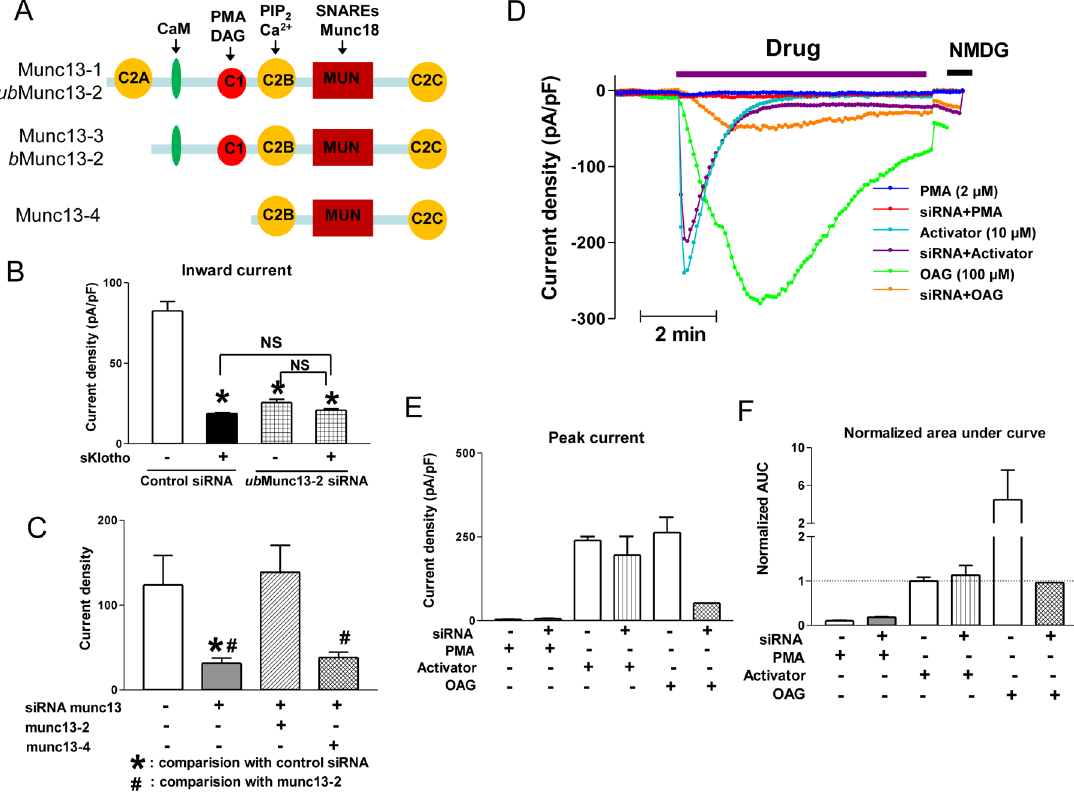
Fig 4. DAG stimulates TRPC6 exocytosis acting at Munc13-2. (A) Functional domains of Munc13 family proteins. ub Munc13-2; ubiquitously expressed Munc13-2; b Munc13-2, brain-specific Munc13-2. C1, DAG (and phorbol ester)-binding domain; C2B, calcium and phospholipid-binding domain; C2A and C2C, homology to C2B, but Ca 2+ -independent; MUN domain, conserved domain for binding Munc18 and SNARE proteins. Domain for calmodulin (CaM) binding (green long oval) is also shown. (B) Effect of Munc13-2 knockdown on inhibition of TRPC6 currents by sKlotho. HEK cells were transfected with GFP-TRPC6 and siRNA against human ub Munc13-2 isoforms or control oligos for ~36 hr before ruptured whole-cell recording of TRPC6 currents. Cells were incubated with sKlotho or vehicle overnight before recording. TRPC6 currents were activated by OAG. Bar graph shows mean ± SEM of peak inward current density at -100 mV, n = 6–8 each. � indicates p < 0.01 vs control (control siRNA and no sKlotho). ns, statistically no significant between indicated. (C) Effect of re-expressing recombinant mouse ubiquitous Munc13-2 or Munc13-4 after Munc13-2 knockdown. (D) Effects of Munc13 knockdown on TRPC6 channels stimulated by OAG or BIRA0411XX (labeled as “activator”). Representative time course tracings of experiments are shown. PMA does not activate TRPC6 and was used as a negative control. (E) Mean ± SEM of peak inward current density of experiments performed in panel D. (F) Mean ± SEM of normalized area under curve (AUC) of inward currents of experiments in panel D.